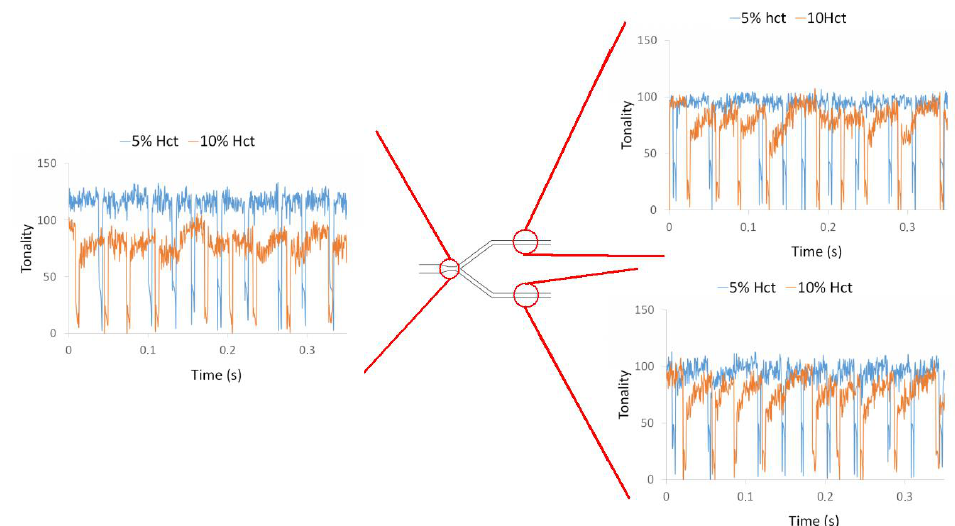
Figure 9. Influence of air bubbles on the local Hct for a flow rate of 10 µL/min for 5% Hct and 10% Hct in bifurcation B2.